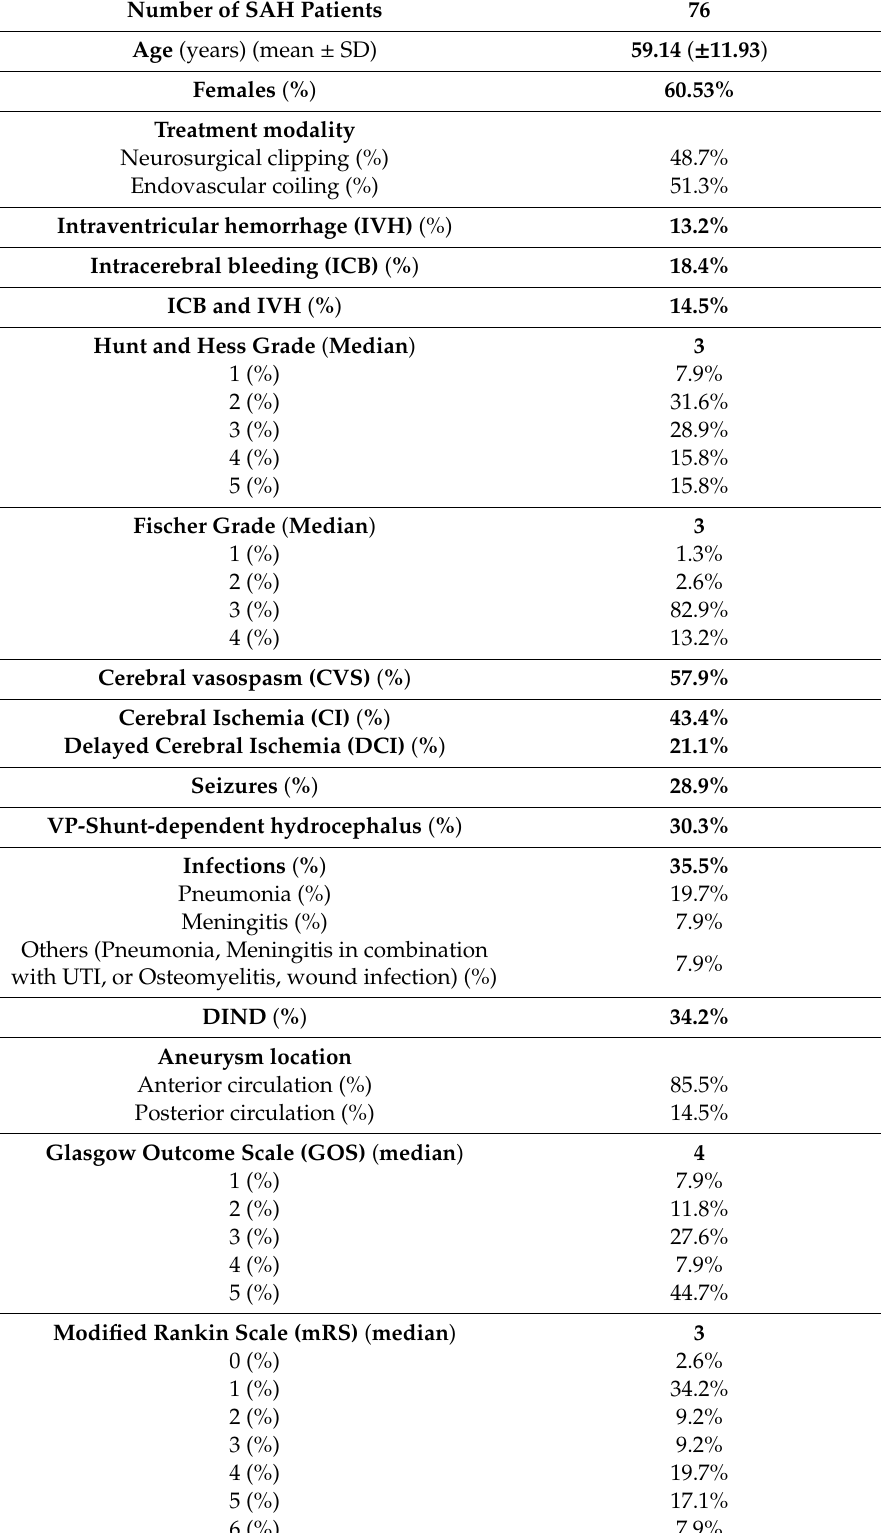
Table 1. Characteristics of aneurysmal subarachnoid hemorrhage (SAH)